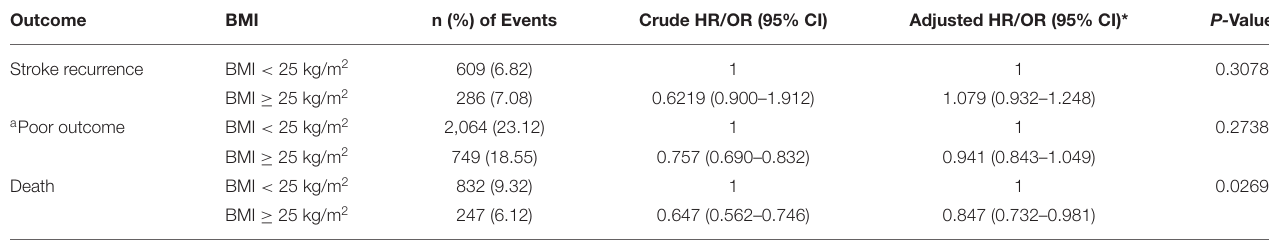
TABLE 2 | Outcomes at 12 months follow up of ischemic stroke, stratified by BMI. Outcome